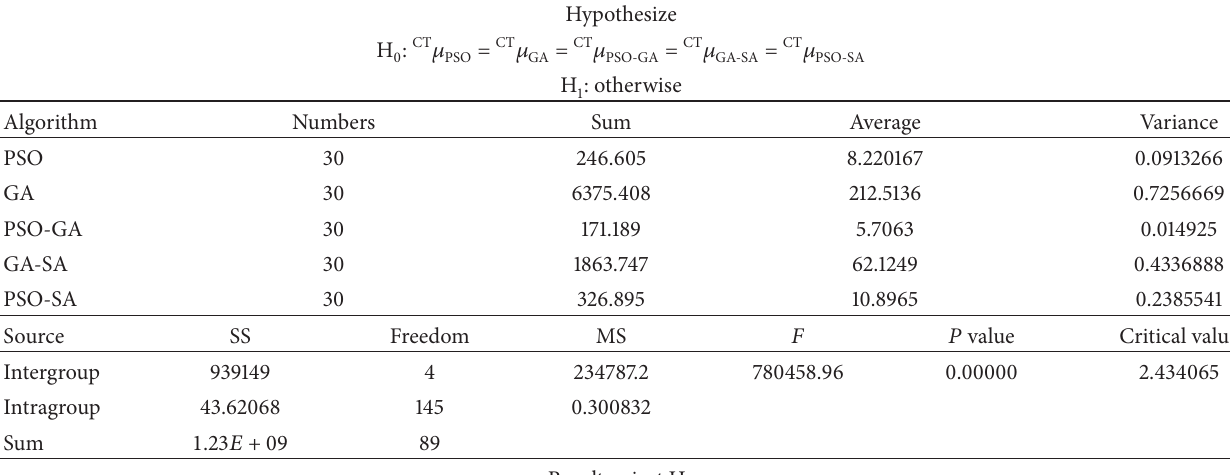
Table 4: ANOVA verification of convergence